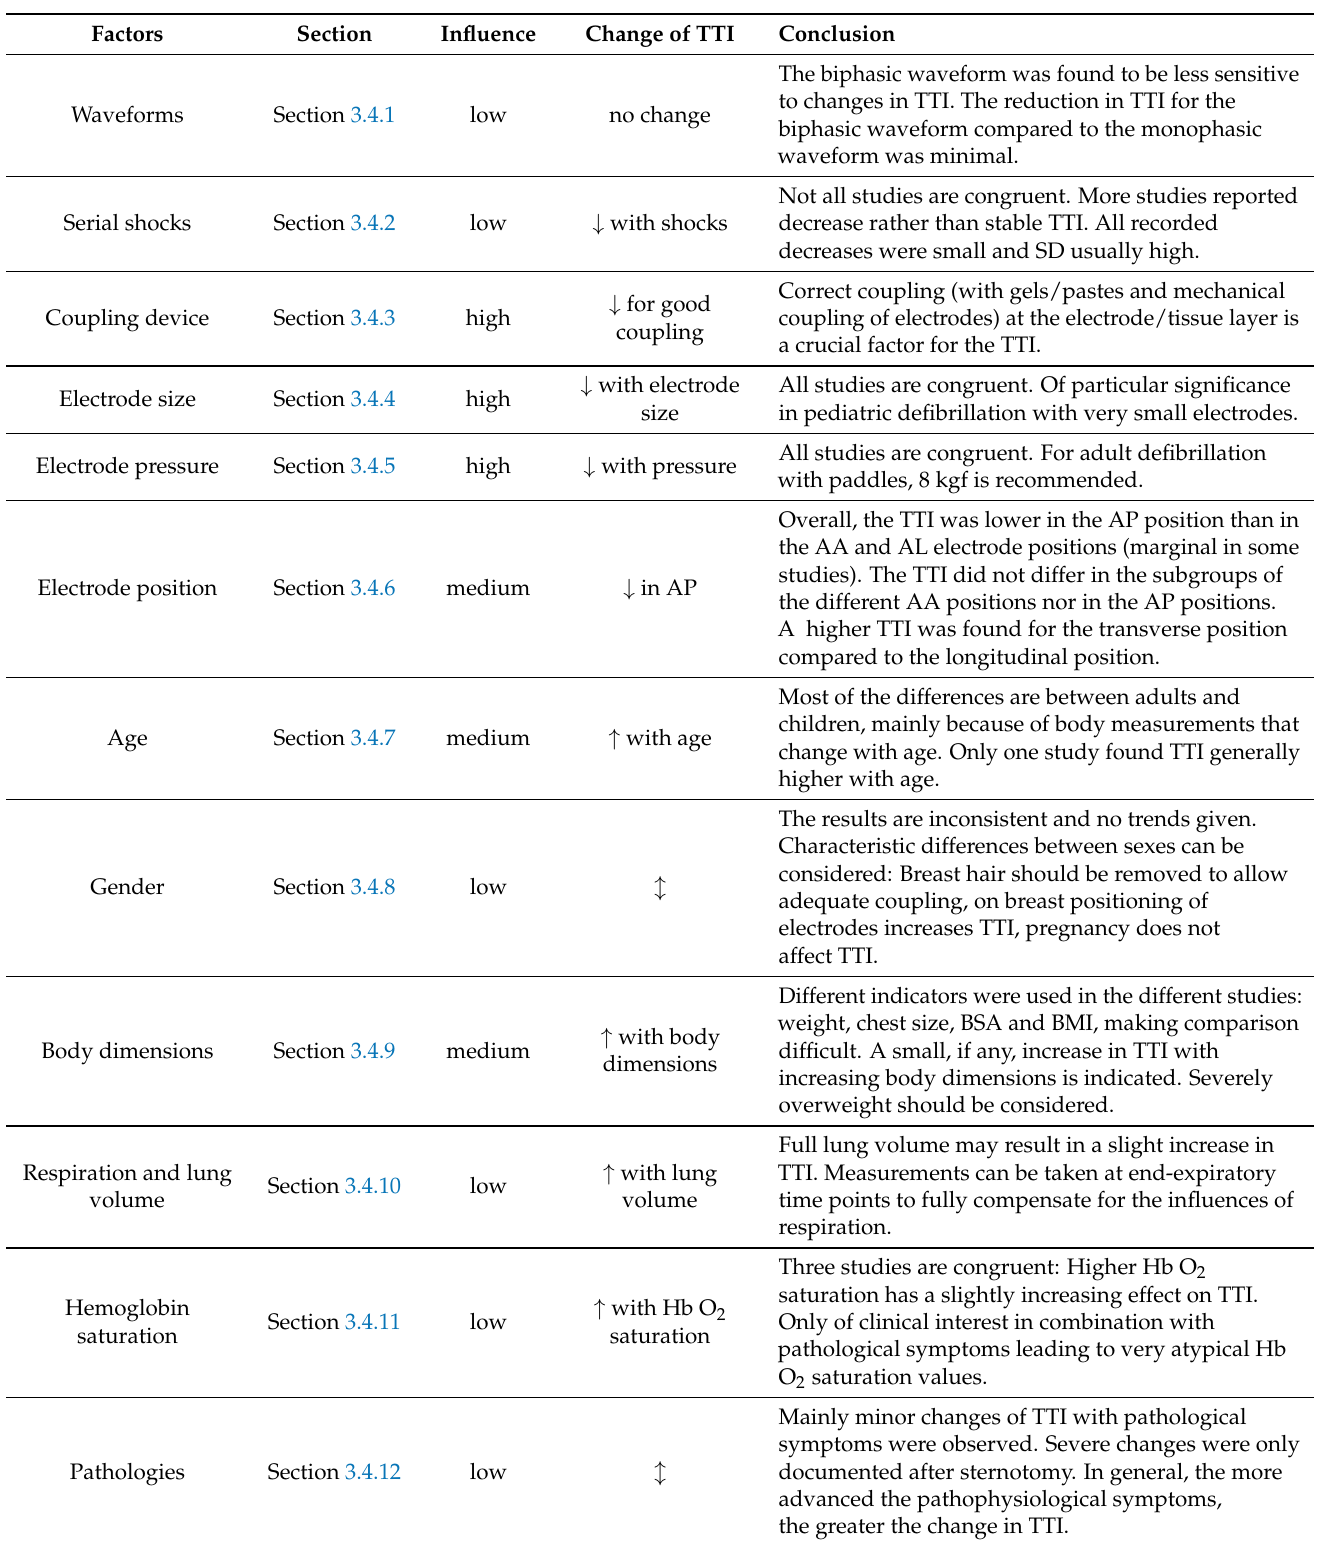
Table 6. Factors influencing TTI found from the literature research are categorized according to the degree of influence (low, medium and high). An increase ( ↑ ) or decrease ( ↓ ) in TTI is represented by the respective